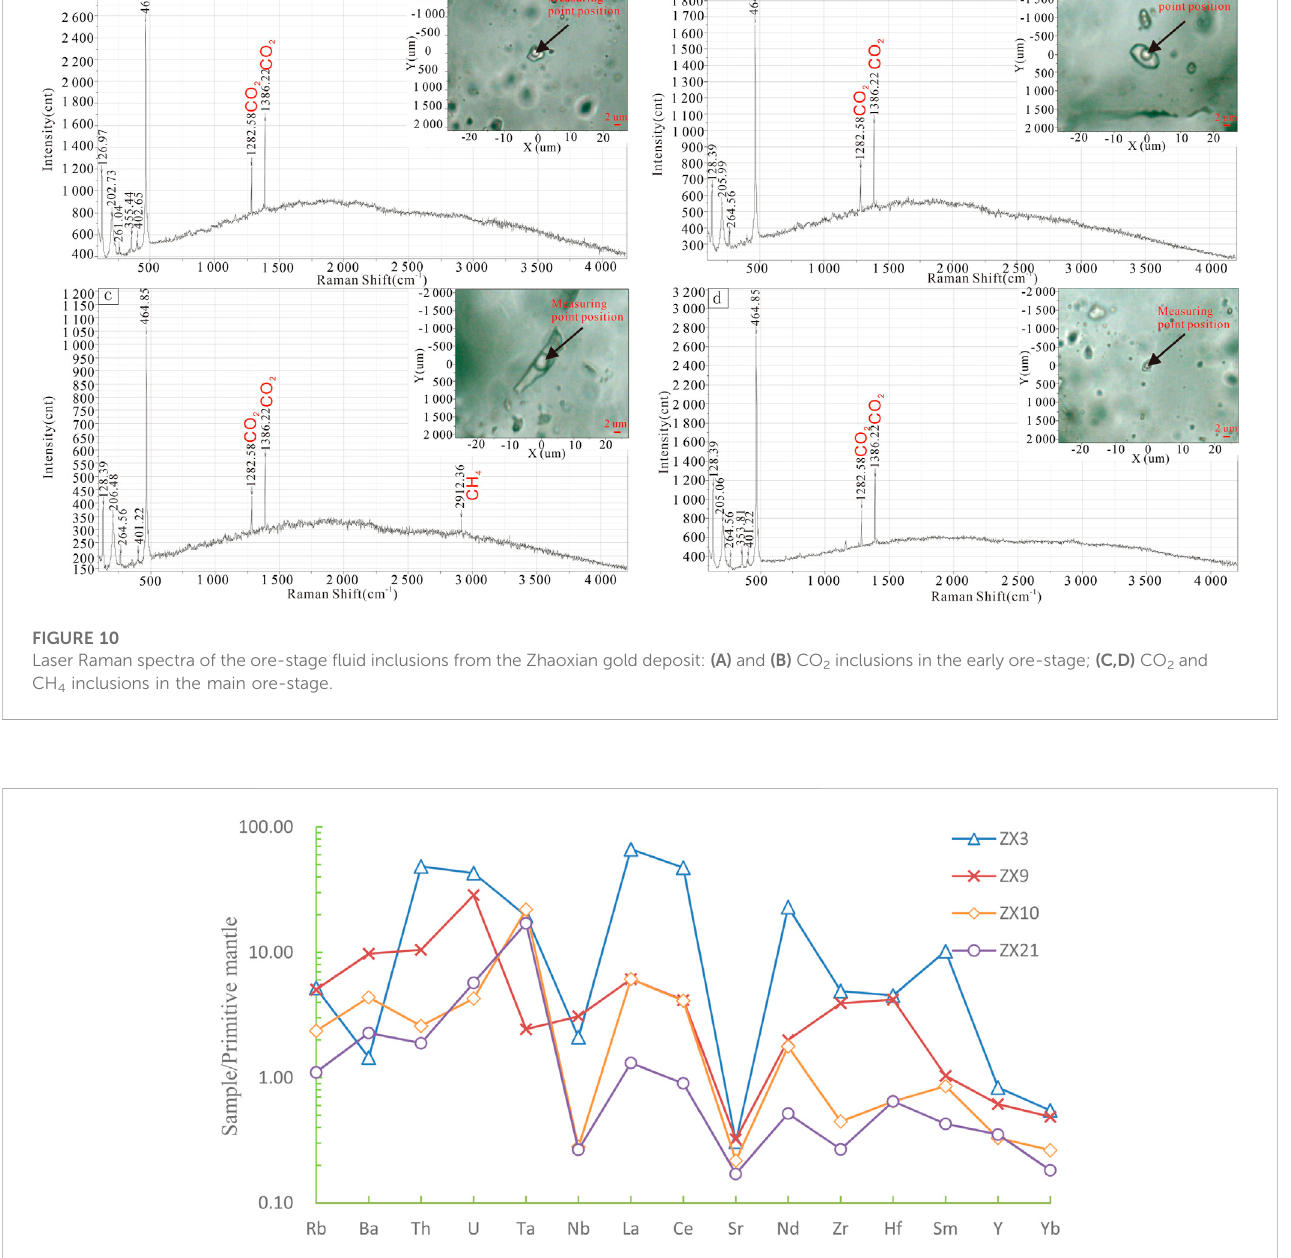
FIGURE 11 Primitive mantle-normalized multi-element spidergram of the syn-ore granite at Zhaoxian.